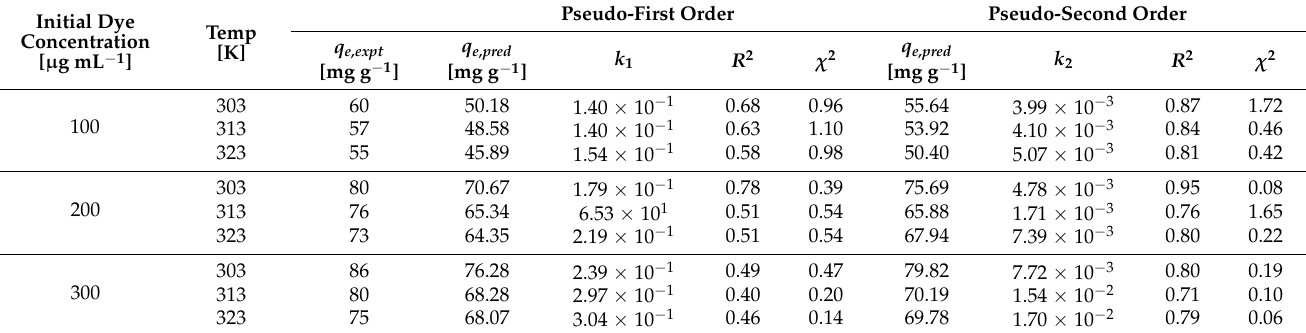
Figure 8 represents the results of the kinetic models developed for DB15. The